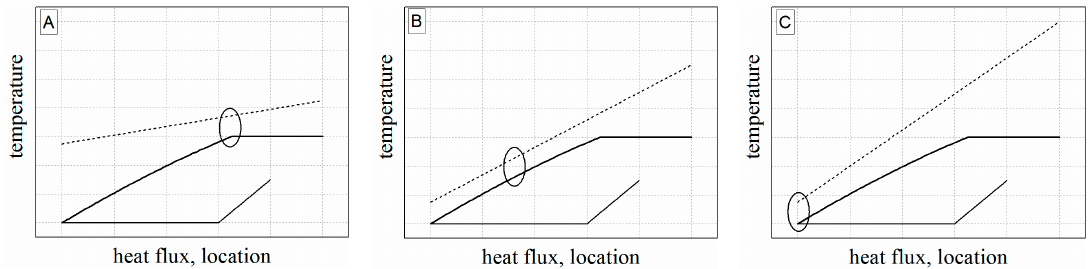
Figure 6. Temperature-heat flow-diagram ( A ) pinch point at beginning of evaporation; ( B ) pinch point during preheating; ( C ) pinch point beginning of preheating).